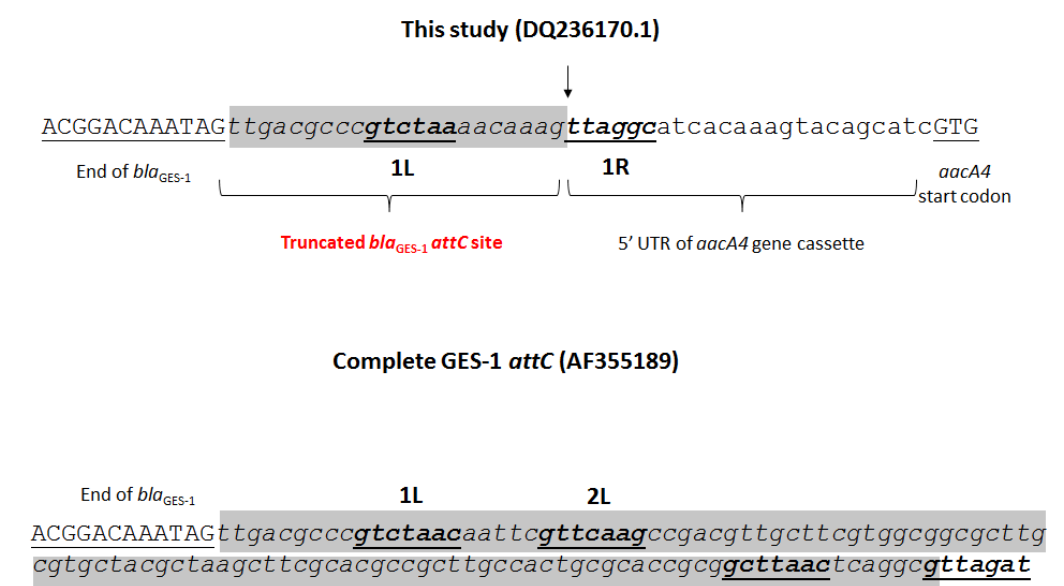
Figure 1. Northern blot analysis of gcu14 - bla cassette array from P. aerginosa class 1 integron. The full length transcript (2,300 bases), corresponding to the entire gene cassette array, hybridized with the GES probe (arrow). The fragment sizes of the RNA marker (Promega) used in RNA electrophoresis are